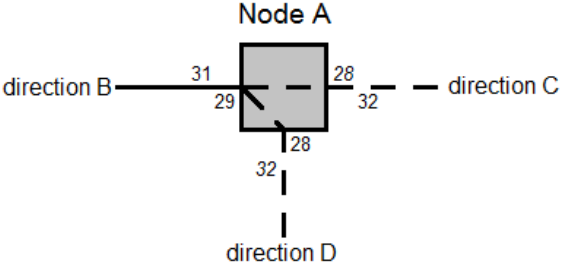
Figure 10. Branching of a public transport line into two directions.